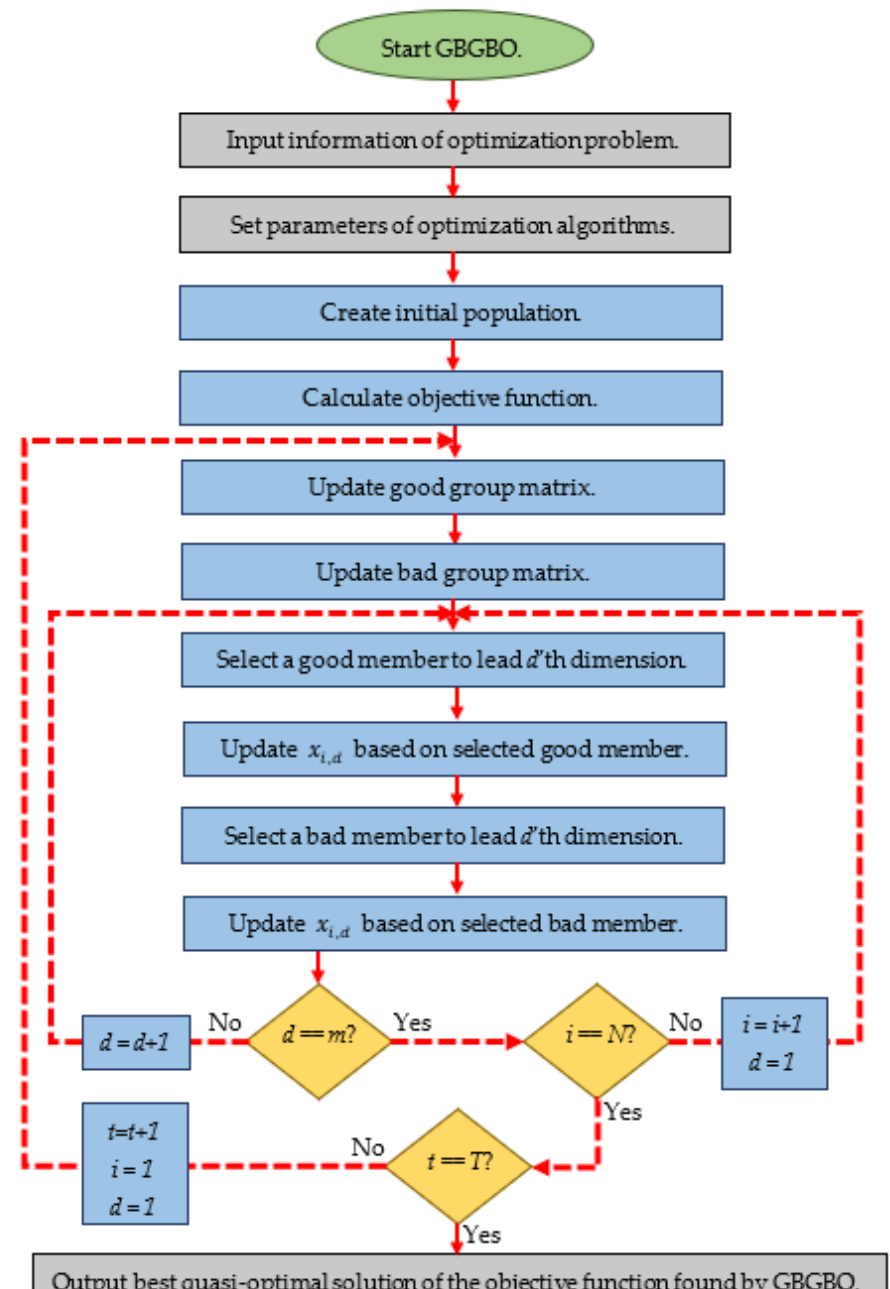
Figure 1. The flowchart of the BGBGO.